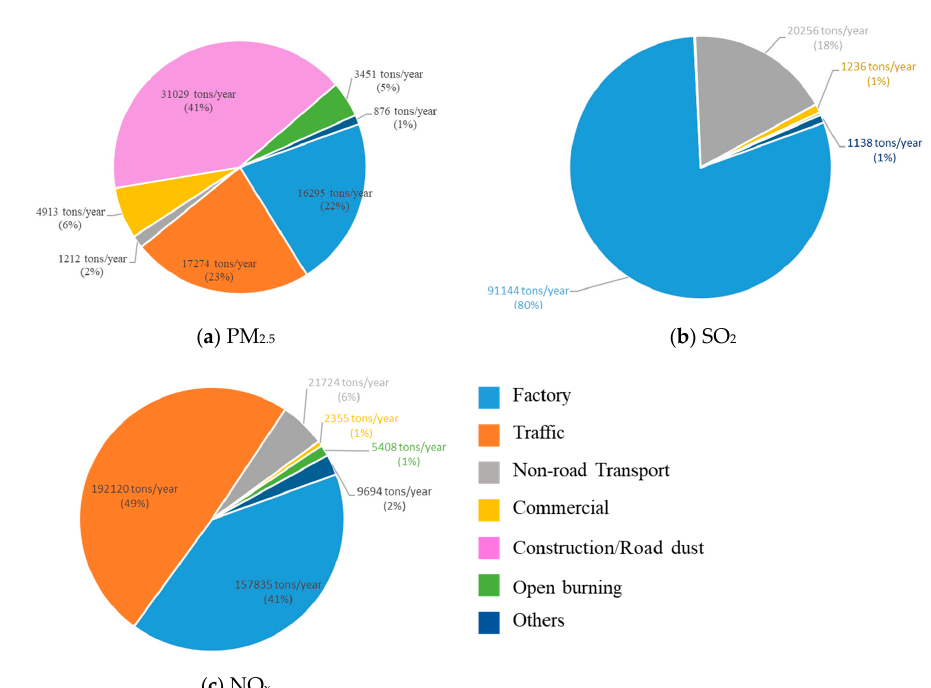
Figure 1. Contribution of pollution sources to ( a ) PM 2.5 , ( c ) NO x , and ( b ) SO 2 pollution in the baseline year (2013). Open data from Taiwan Government [37].